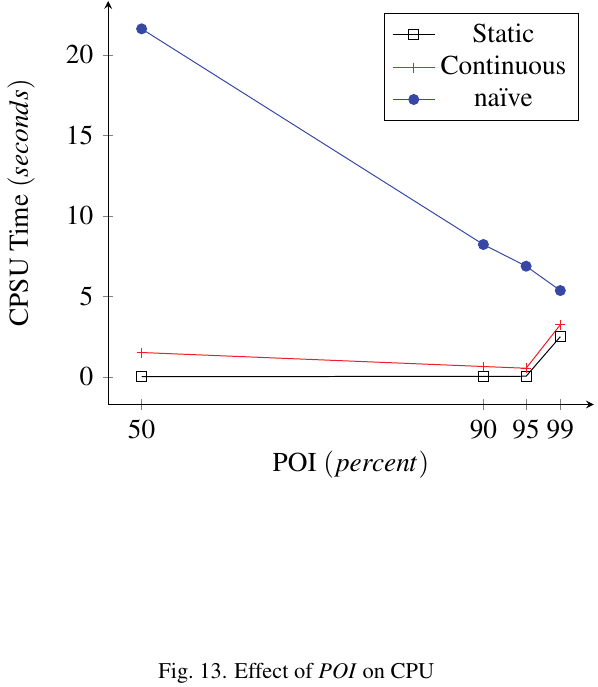
Fig. 13. Effect of POI on